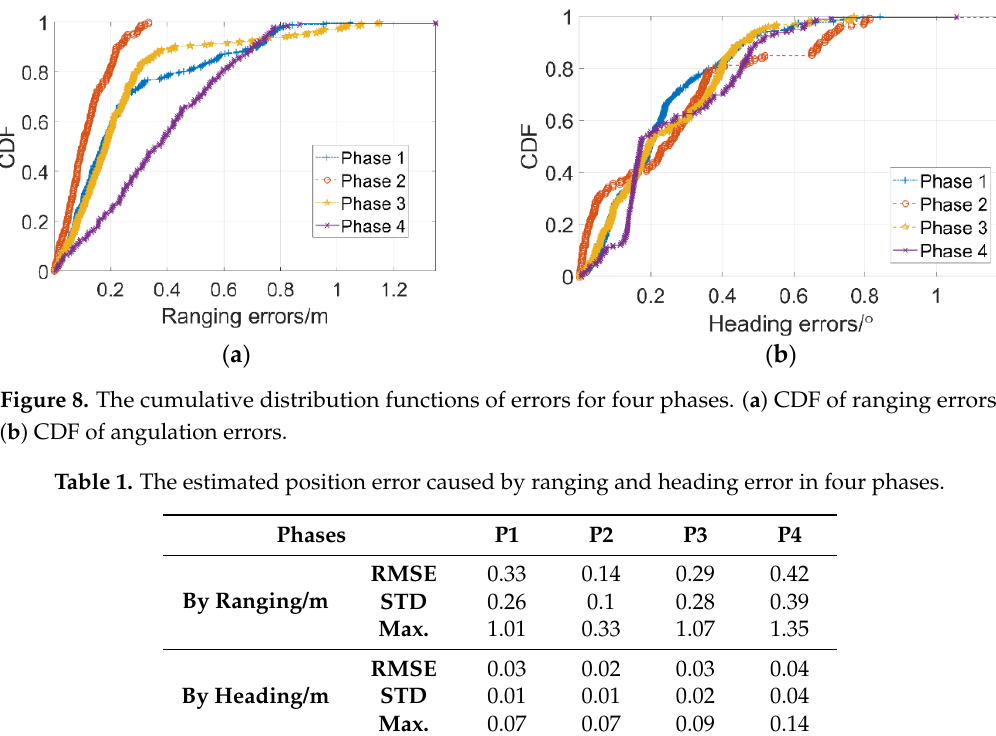
Figure 7. The contour map of measurements errors. ( a ) Ranging errors; ( b ) angulation errors.